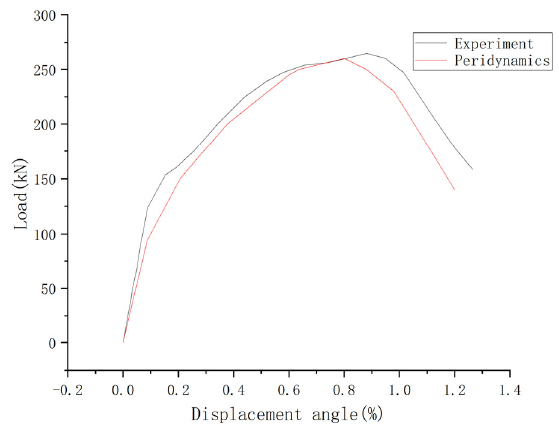
Figure 8. Load-displacement curve [12].